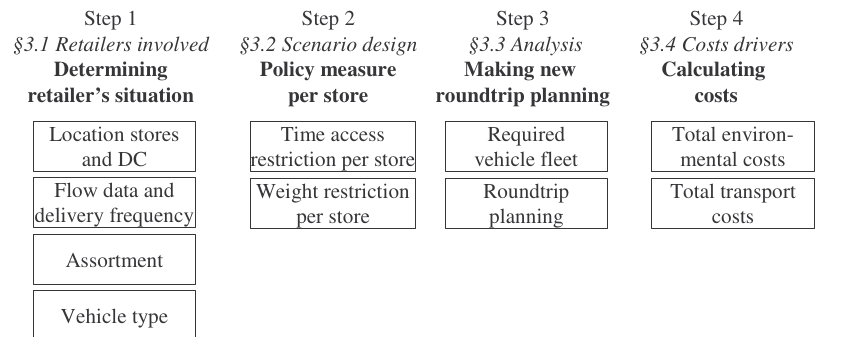
Figure 2. Outline of